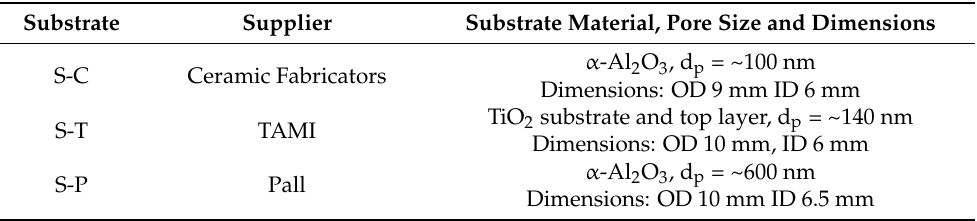
Figure 2. Schematic of the pervaporation experimental set up.